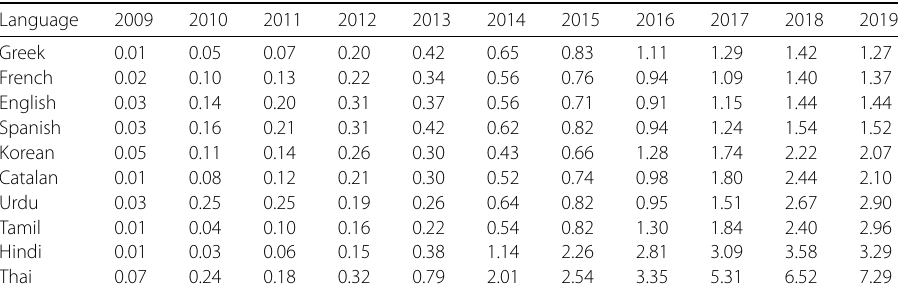
Table 2 Top 10 languages with the highest annual average contagion ratio (sorted by 2019)